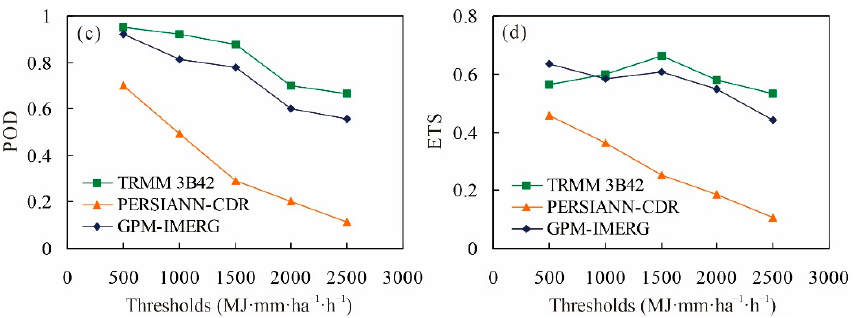
Figure 7. Changes in FBI ( a ), FAR ( b ), POD ( c ), and ETS ( d ) scores at different thresholds on the monthly scale.